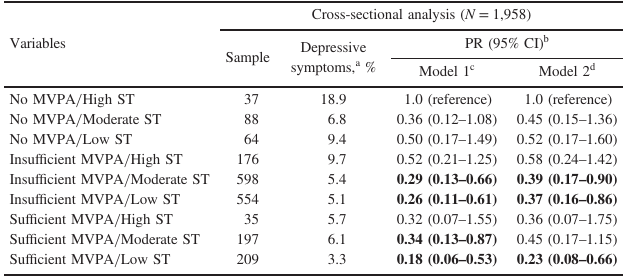
Table 2. Joint associations of moderate-to-vigorous physical activity and sedentary time with depressive symptoms: cross-sectional analysis